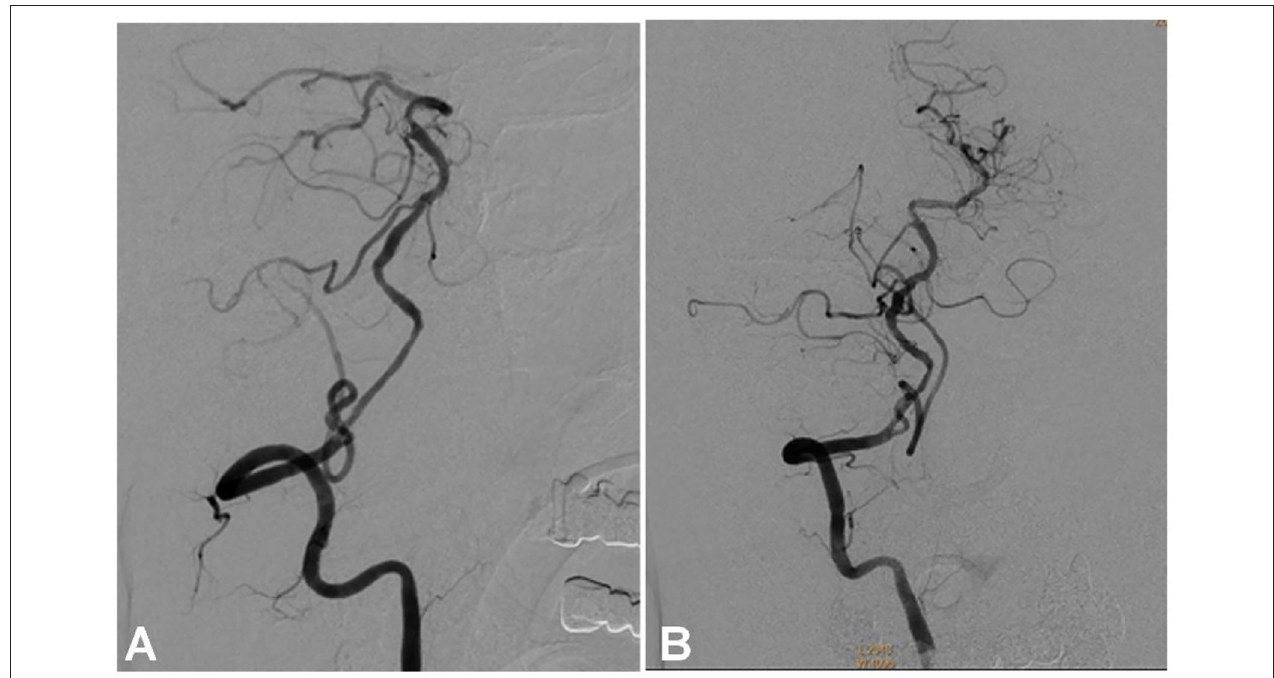
FIGURE 5 | Follow-up angiography at 6 months after stenting demonstrates unobstructed blood flow through the stented vertebral artery (A,B) with no stenosis.